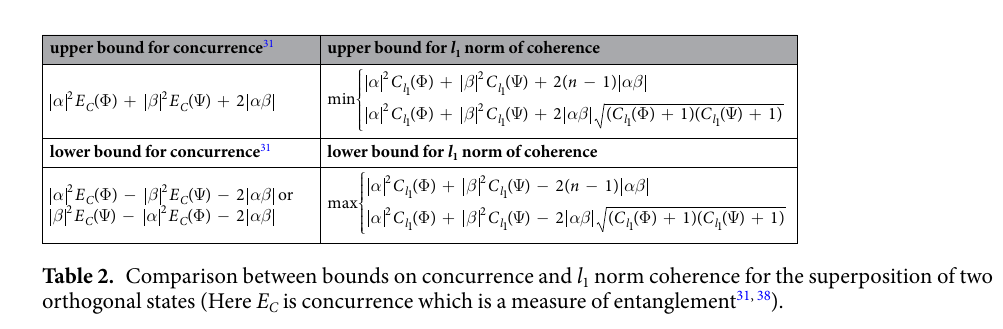
is an entanglement measure of pure A